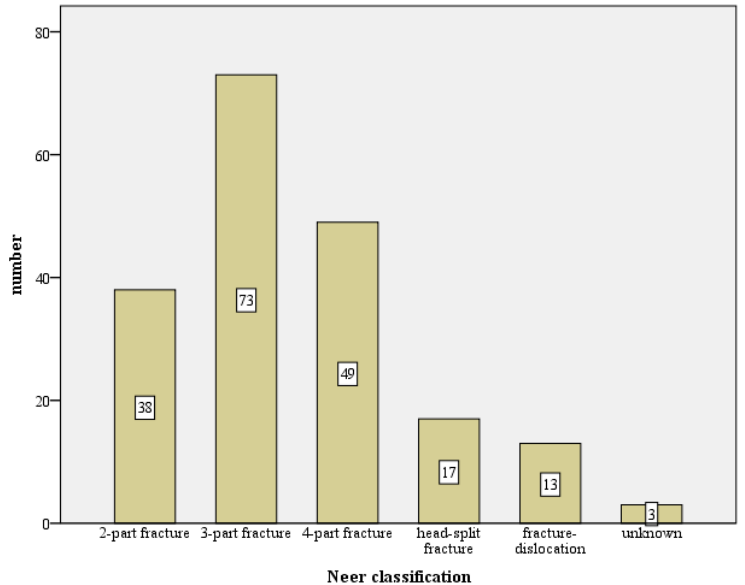
Figure 3. Absolute fracture distribution of the total collective, based on the Neer classification, total number n = 1047 (X-axis: Neer classification, Y-axis: number).